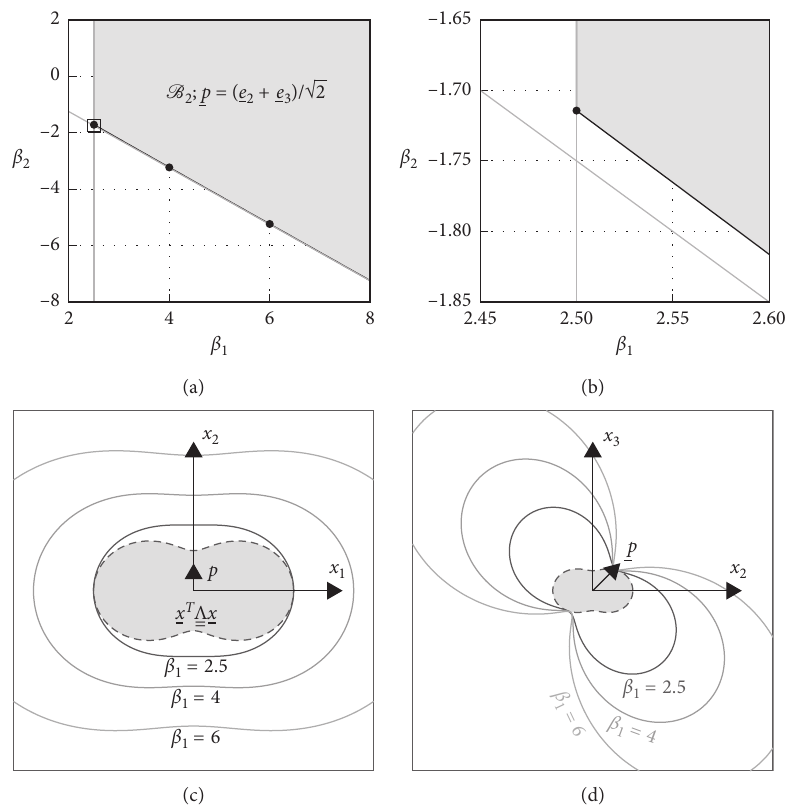
Figure 4: (a) Parameter region B of the quadratic forms x T Λ x and x T B quadratic forms in the (2,3)-plane.